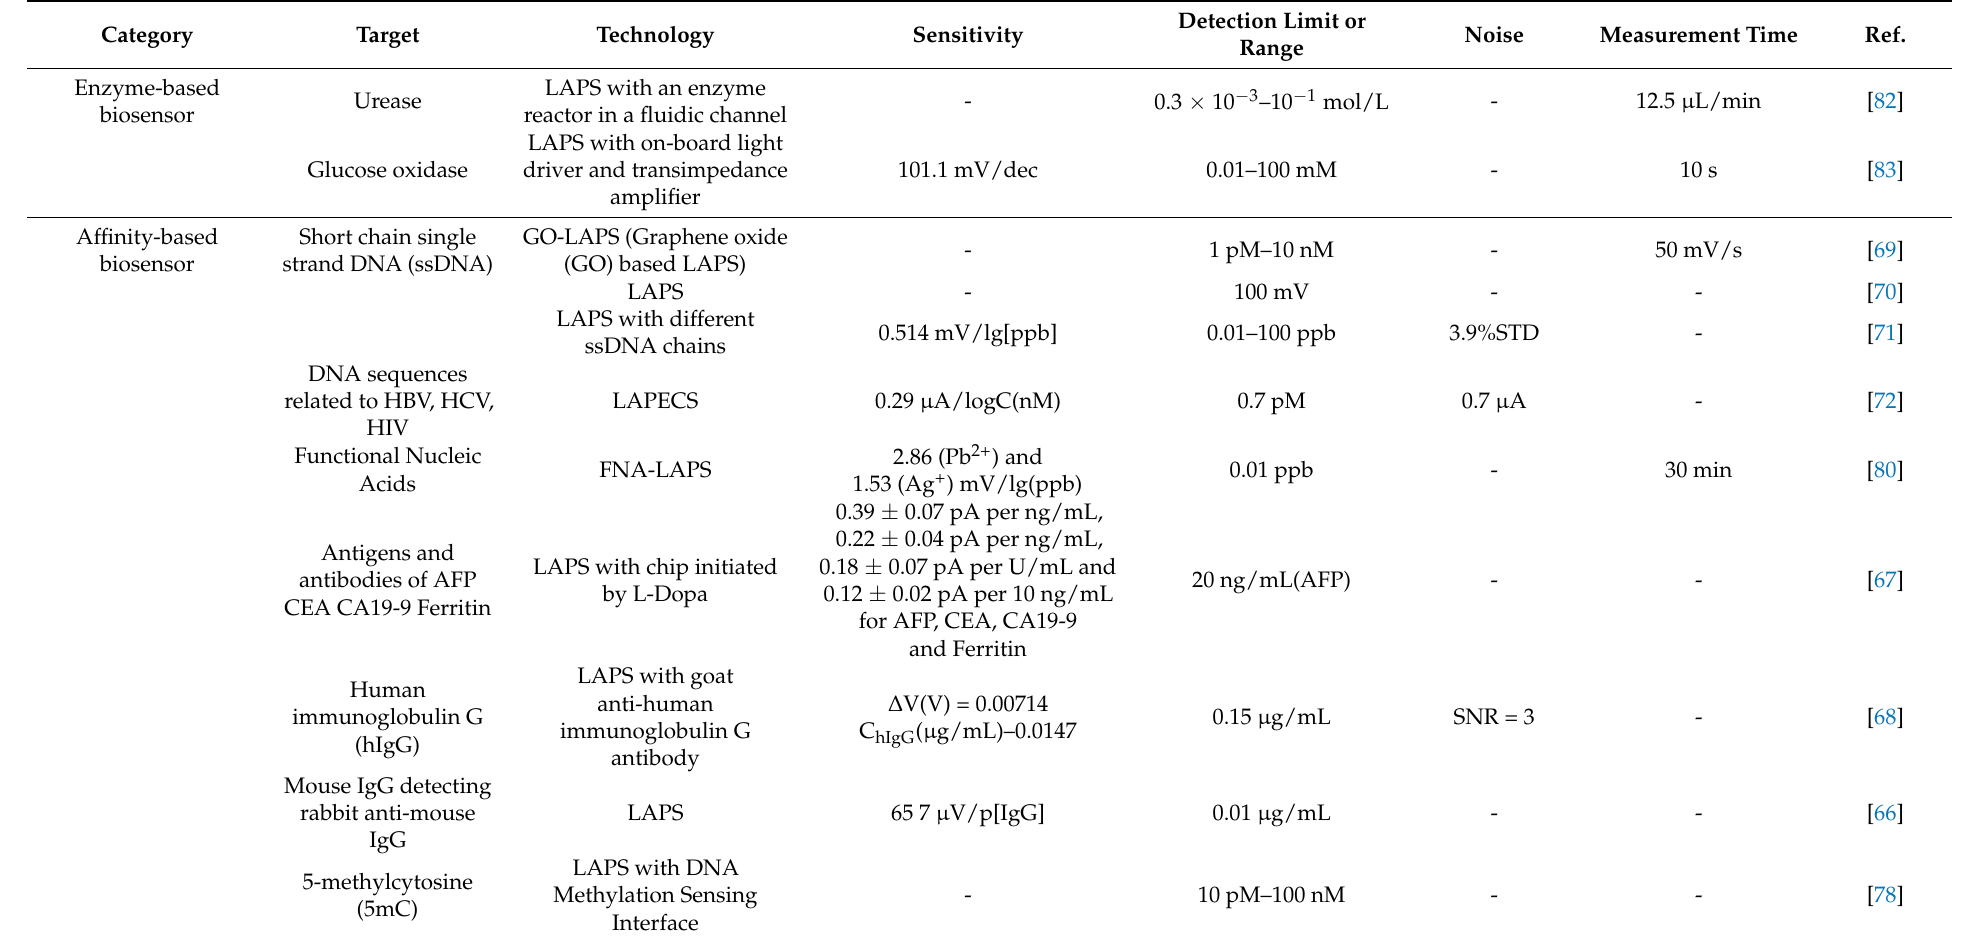
Table 3. Categories, targets, technology, sensitivities, detection limits or ranges, noise and measurement times of articles on LAPS biosensing and imaging published in recent